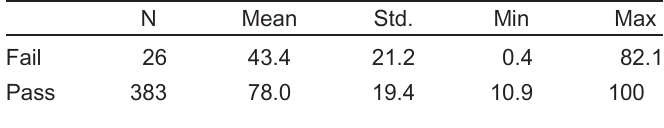
Table 4 . The mean percentile scores of the residents that failed the American Osteopathic Board of Emergency Medicine (AOBEM) Part 1 were significantly lower than the scores of the residents who passed the AOBEM Part 1 (p , 0.001).